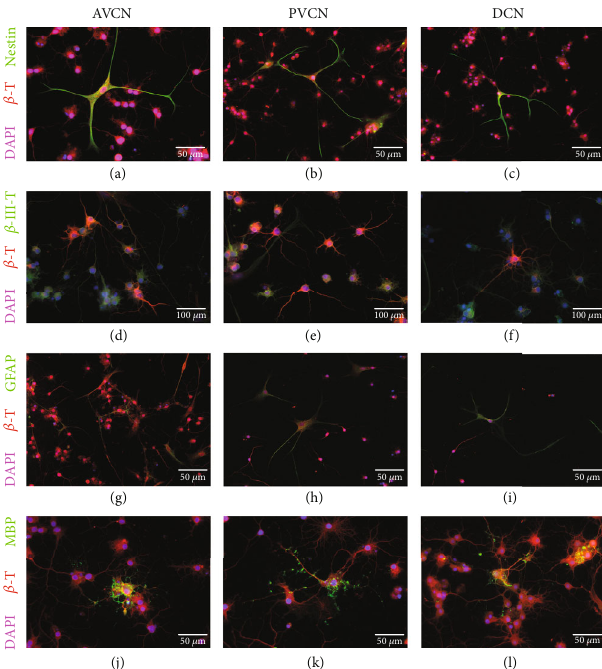
Figure 3: Neural stem cells of all CN subnuclei can di ff erentiate into the cell forms of the neuroectodermal line. (a – c) Undi ff erentiated cells showed a positive staining for the progenitor cell marker nestin. (d – f) Neuronally di ff erentiated cells were identi fi ed by β - III-tubulin staining (red). These cells had slim, spindle-shaped, neuron-typical somata with bi- and multipolar formations. (g – i) Astrocytes were identi fi ed by GFAP staining (glial fi brillary acidic protein). These cells showed an astrocyte-typical stellate-shaped formation with multipolar branches. (j – l) Oligodendrocytes were stained with MBP (myelin basic protein). These showed a beginning myelinization of the peripheral processes, while the still unmyelinated cell bodies were stained β -tubulin ( β -T) positive. Cell nuclei were stained with